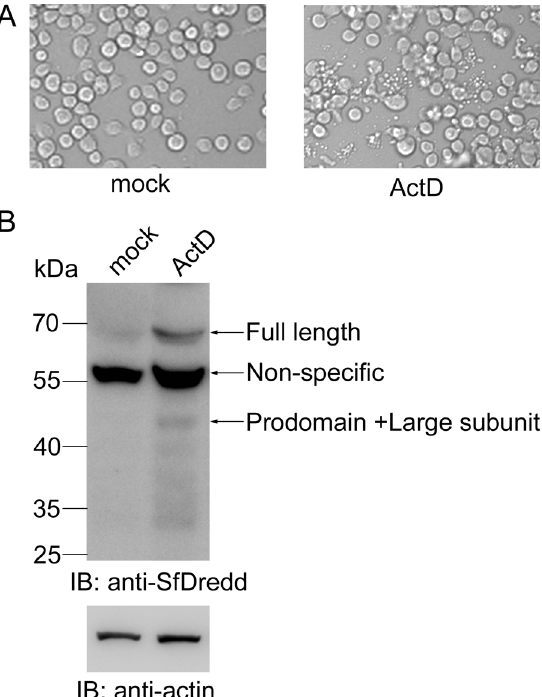
Fig 8. The protein level of SfDredd increased in ActD-treated Sf9 cells. Sf9 cells were treated with ActD at a final concentration of 250 ng/mL. (A) Cell pictures were taken 6 h post ActD treatment (magnification ×200). (B) Sf9 cells were harvested 6 h after ActD (250 ng/mL) treatment, and cell lysates were analyzed by immunoblotting using antibody against